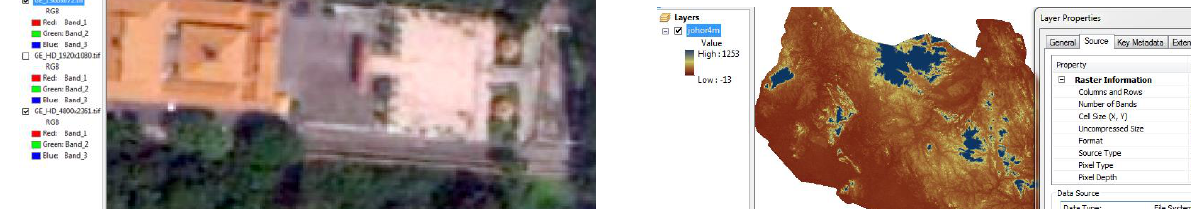
Figure 12a. Minimum resolution (1366 x 672) – blurred image